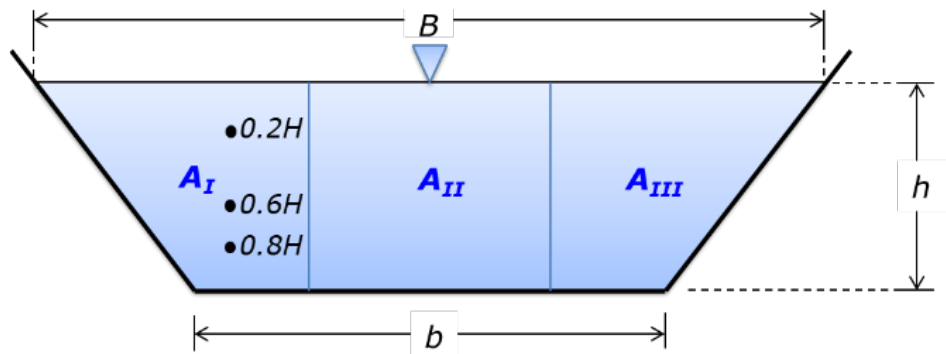
Figure 5. The illustration of the discharge measurement, consisting of a separation of the channel cross-section area into three segments ( A I , A II , and A III ). The velocity was measured at three different depths (0.2 H , 0.6 H , and 0.8 H ).